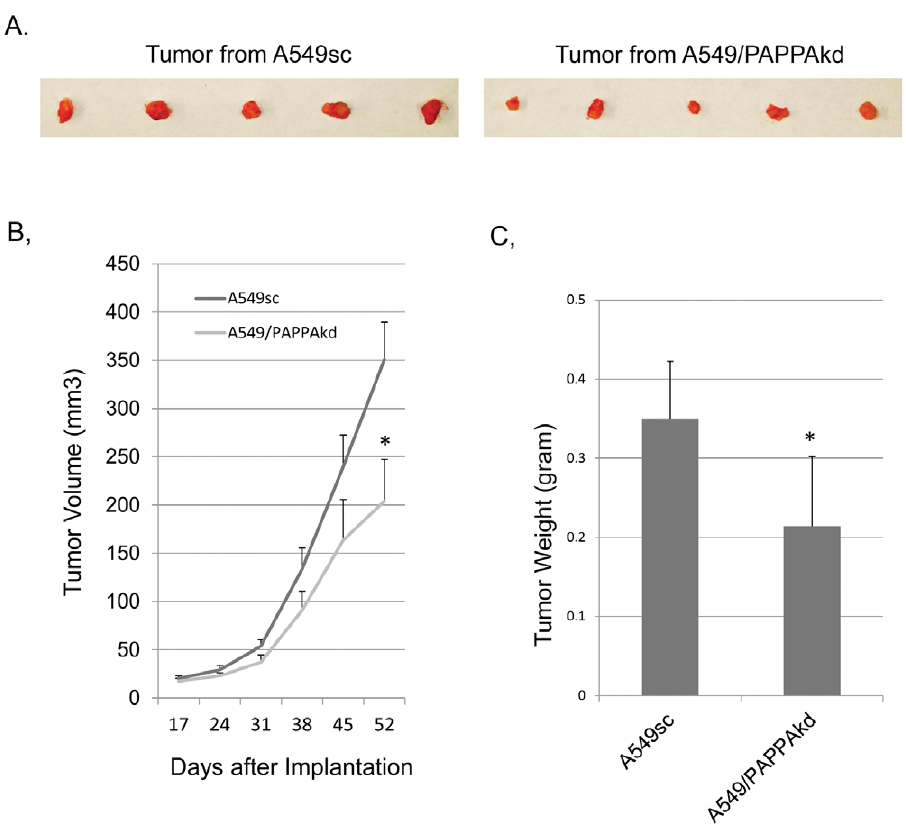
Figure 3. Effect of PAPPA down regulation on xenograft tumor growth. (A) Image of tumor size at the time of dissection. (B) Growth curve of xenograft tumor. PAPPA knockdown A549 cells line A549/PAPPAkd and non-silencing control A549sc were injected subcutaneously into 4 weeks old nu/nu athymic mice as described in the Materials and Methods. Results were expressed as mean tumor volume (mm 3 ) 6 SD (n=5). (C) Wet tumor weight at the time of dissection. *: p , 0.05 (student t test).